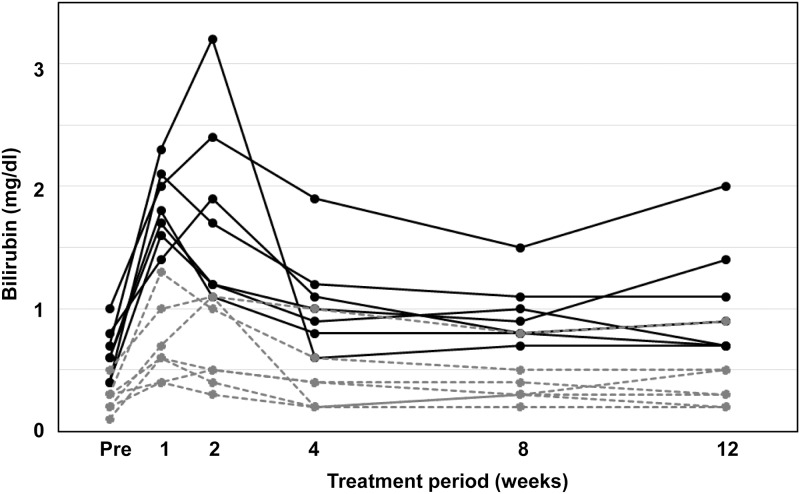
Individual time course of serum bilirubin concentration in seven patients treated with paritaprevir who developed hyperbilirubinemia (≥ 1.6 mg/dl).Black line, total bilirubin; gray dotted line, direct bilirubin.